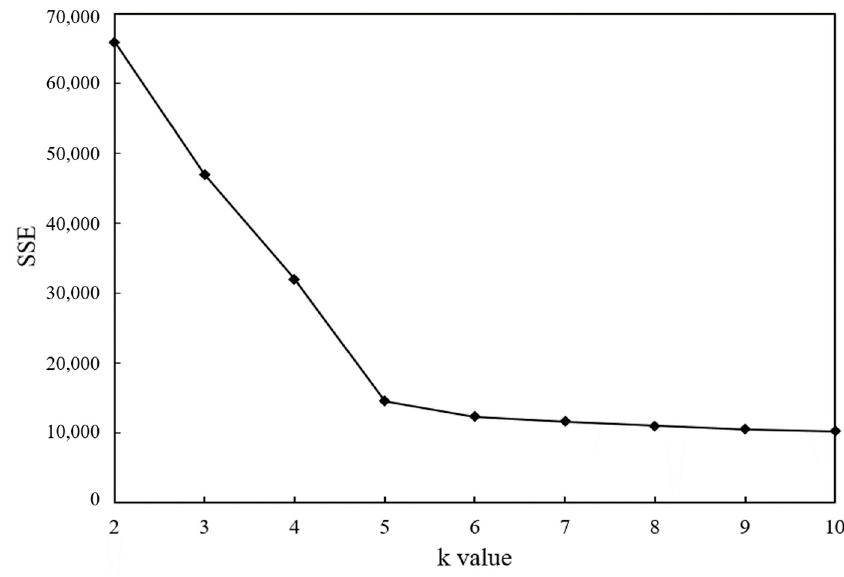
Figure 9. Relationship between SSE and k values.